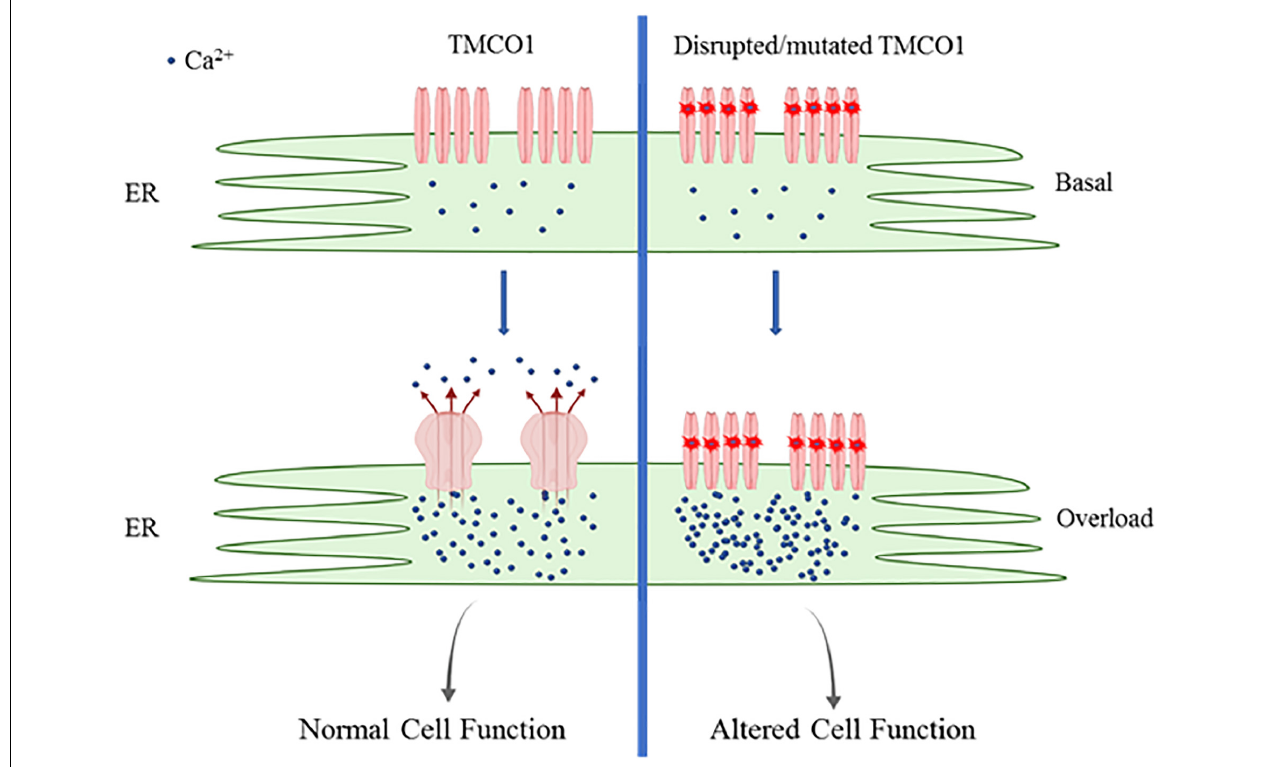
FIGURE 1 | Schematic of TMC01 function. TMCO1 exists as monomers and dimers during basal ER Ca 2 + load. ER Ca 2 + reaching overload results in oligomerization to form active TMCO1 tetrameric channels, facilitating Ca 2 + release. Channels undergo rapid disassembly once basal Ca 2 + levels are restored. Mutated TMCO1 is unable to assemble to form active channels resulting in persistent ER Ca 2 + overload.